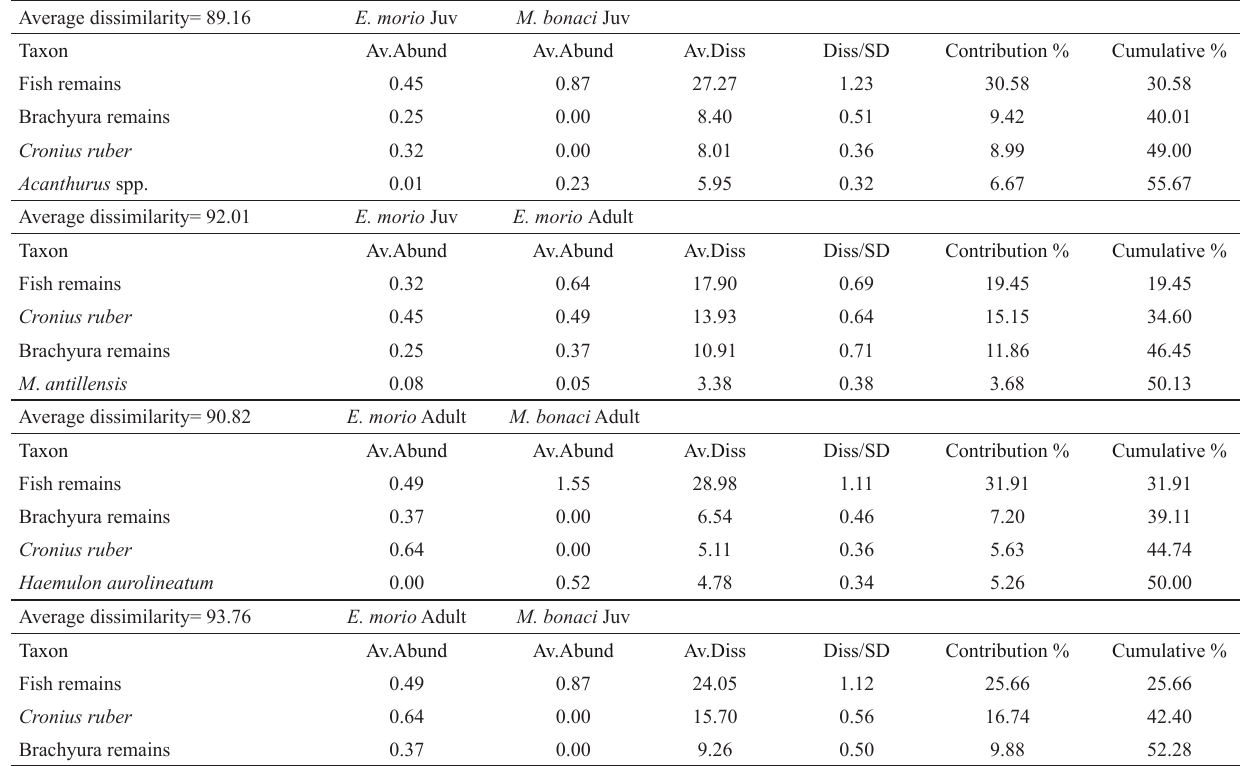
Tab. 3. Results from two-way crossed similarity of percent (SIMPER) analyses for significant species/stage effects. Species contributions that summed cumulatively to >75% are shown. Juv = Juvenile, Av.Abund = Average abundance, Av.Diss = Average dissimilarity, Diss/SD = Dissimilarity Standart Deviation. Average dissimilarity= 89.16